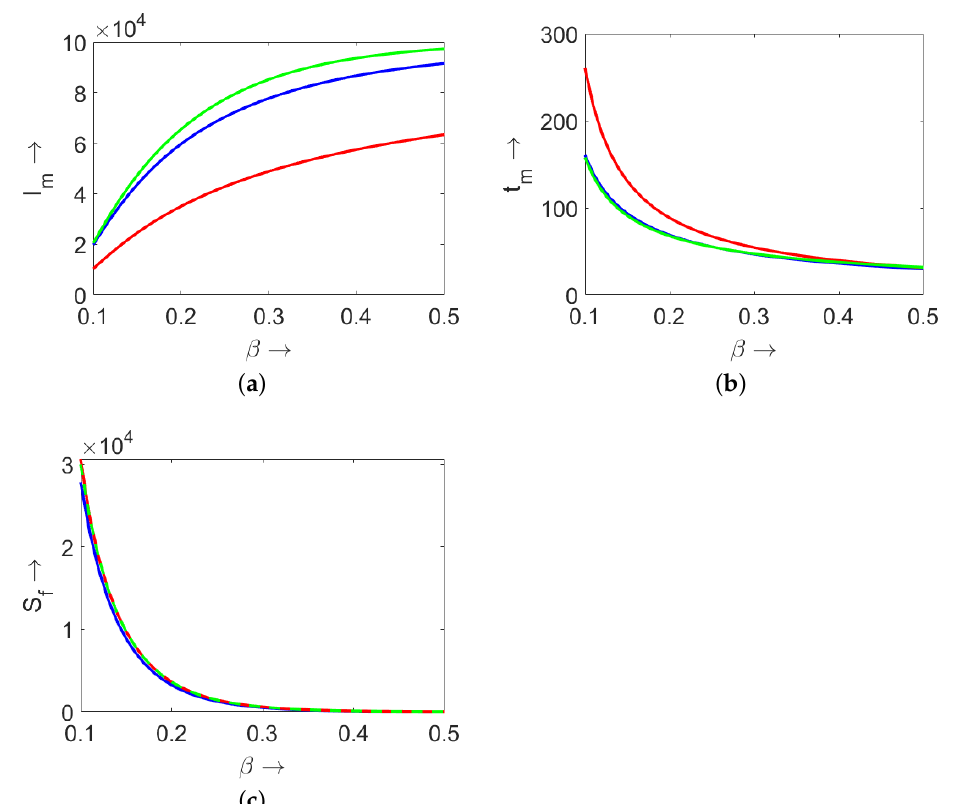
Figure 5. Comparison of the maximal number of infected individuals I m ( a ), the time to reach the maximal number t m ( b ), and the final size of the epidemic S f ( c ) for the distributed model (3) (blue curves), the delay model (9) (green curves), and the SIR model (4) (red curves) for different values of β . The values of parameters: N = 10 5 , I 0 = 1, for the SIR model r 0 + d 0 = 1/17.7; for the delay model τ = 17.7; for the distributed model (3): a 1 = 8.06275, b 1 = 2.21407, a 2 = 6.00014, b 2 = 2.19887, p 0 =